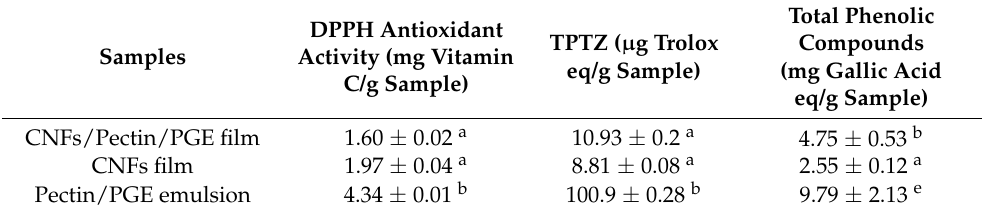
Table 7. Total phenolics and antioxidant activity profile of CNFs film, Pectin/PEG emulsion, and CNFs/Pectin/PGE film.